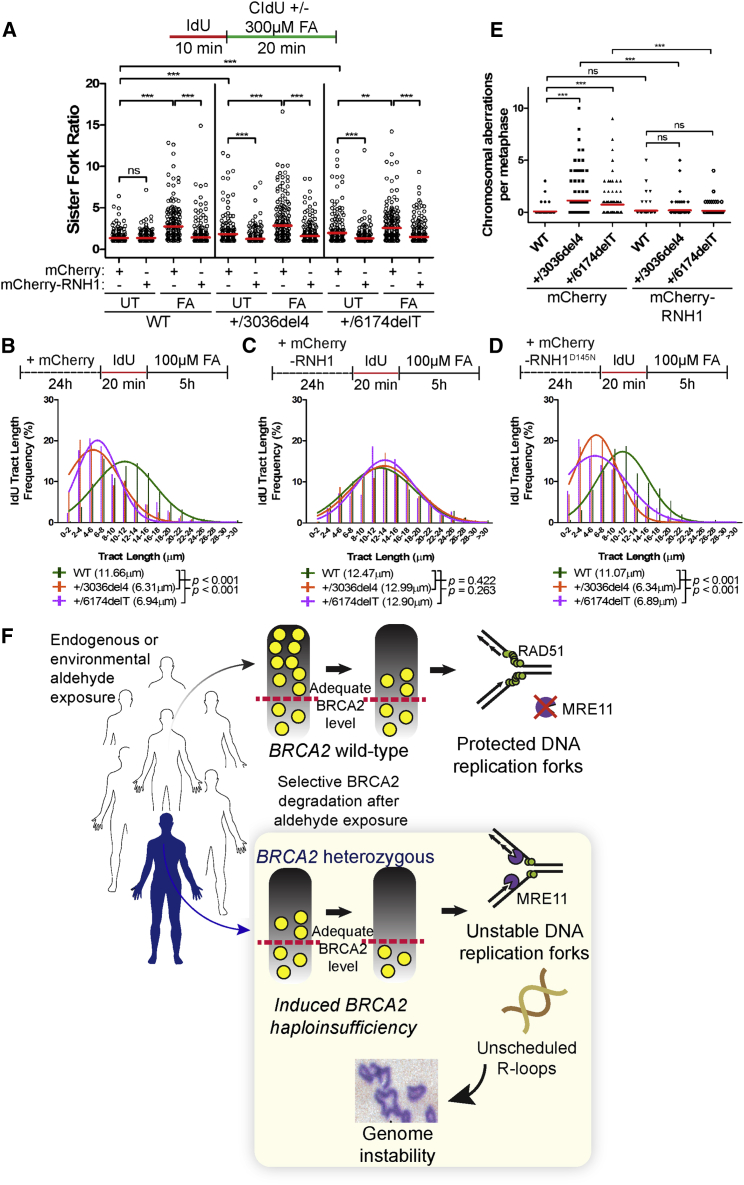
Ribonuclease H1 Ameliorates Formaldehyde-Induced Replication Stress and Genome Damage(A) DNA fiber assay comparing sister fork symmetry in HeLa Kyoto cells expressing mCherry or mCherry-RNase H1 (RNH1) vectors with or without FA treatment. The scatterplot compares the ratio of sister-fork tract lengths between the different conditions with red lines indicating the median, n = 2.(B) IdU tract length frequency distributions of HeLa Kyoto cells transiently expressing mCherry after FA exposure for 5h.(C) IdU tract length frequency distributions of HeLa Kyoto cells transiently expressing mCherry-RNase H1 after FA exposure for 5h.(D) IdU tract length frequency distributions of HeLa Kyoto cells transiently expressing mCherry-RNase H1 (D145N) after FA exposure for 5h. Results of (B)–(D) represent at least two independent experiments.(E) Frequency of chromosomal aberrations in HeLa Kyoto cells expressing either mCherry or mCherry-RNase H1 following 5 hr treatment with 100 μM FA. Red lines indicate the mean, n = 2.(F) Aldehyde-induced haploinsufficiency in BRCA2 heterozygous cells. Aldehyde exposure triggers selective BRCA2 degradation in the cells of both wild-type individuals as well as those who carry heterozygous BRCA2 mutations. Adequate levels of BRCA2 remain in wild-type individuals. But in BRCA2 heterozygous mutation carriers, aldehyde-induced degradation decreases BRCA2 levels below the threshold of adequacy, engendering “induced haploinsufficiency.” These events expose stalled DNA replication forks to MRE11 activity, engendering chromosomal aberrations via R-loop formation.See also Figure S7.